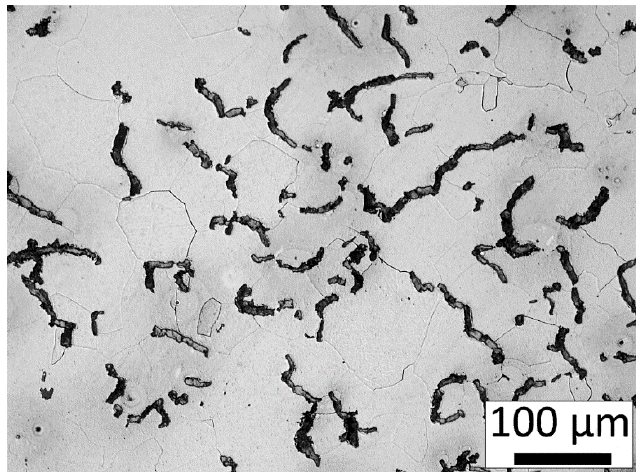
Figure 7. Optical micrograph of the CGI-2 specimen; thickness: 75 mm (Fully ferritic).